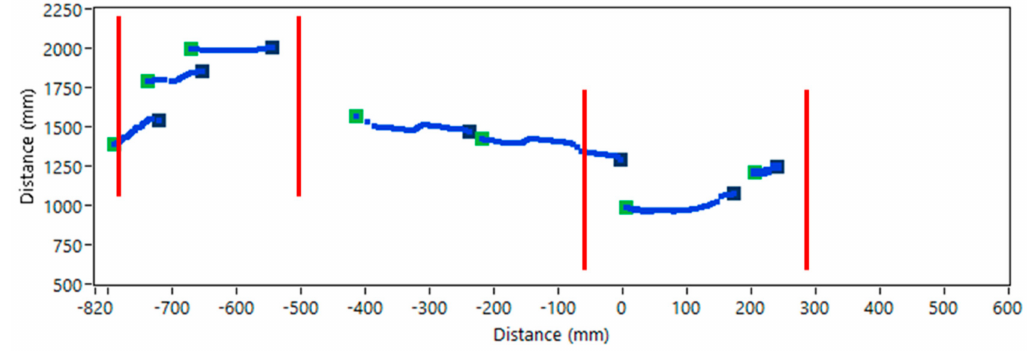
Figure 13. The scanline with added human pose borders are represented by red lines. Green dots represent the start of the cluster, black dots represent the end of the cluster, and blue plots represent clusters from laser data.